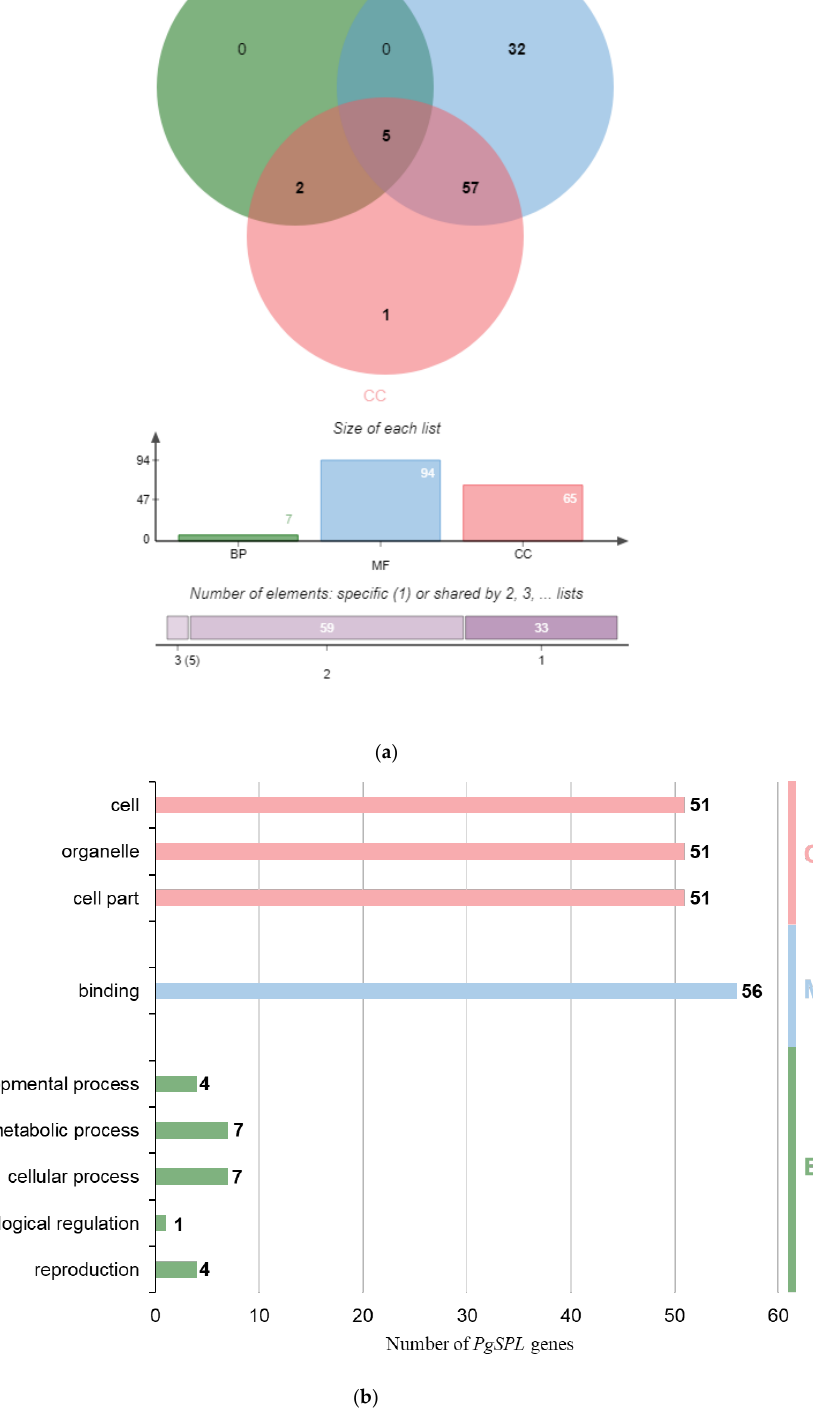
Figure 1. Functional categorization of the PgSPL transcripts by gene ontology (GO). ( a ) Venn diagram of the PgSPL transcripts among the biological process (BP), molecular function (MF) and cellular component (CC) functional categories. ( b ) The PgSPL transcripts are classified into 9 functional categories at Level 2, including three CC functional categories (Red), one MF functional category (Blue), and five BP functional categories (Green).